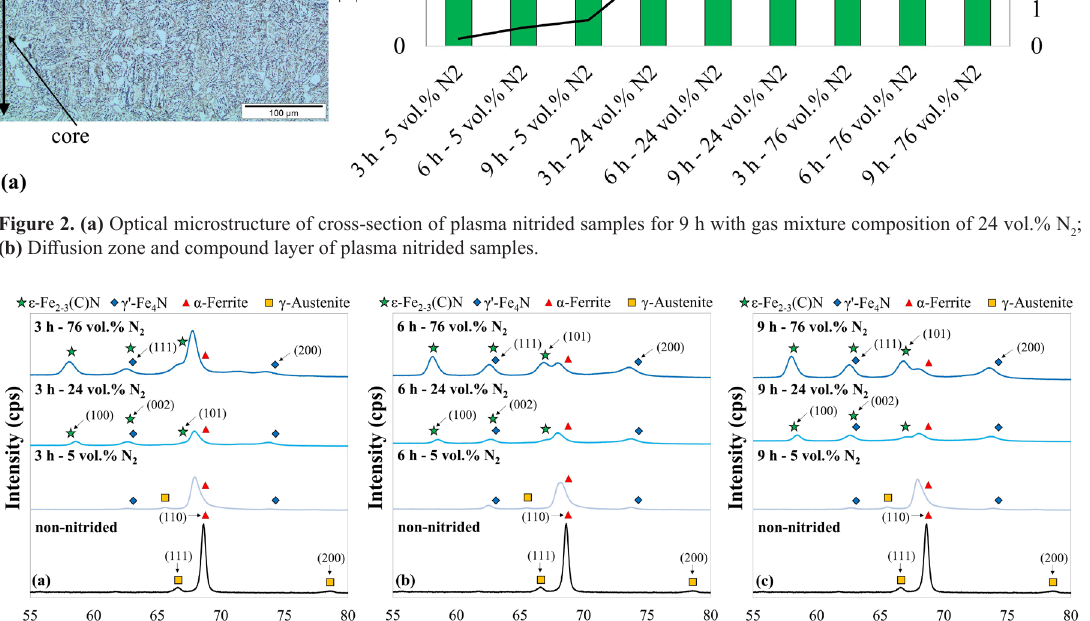
Figure 3. X-ray diffraction patterns of non-nitrided and plasma nitrided samples, with the indicated gas compositions (5, 24, and 76 vol.% N for (a) 3 h, (b) 6 h, and (c) 9